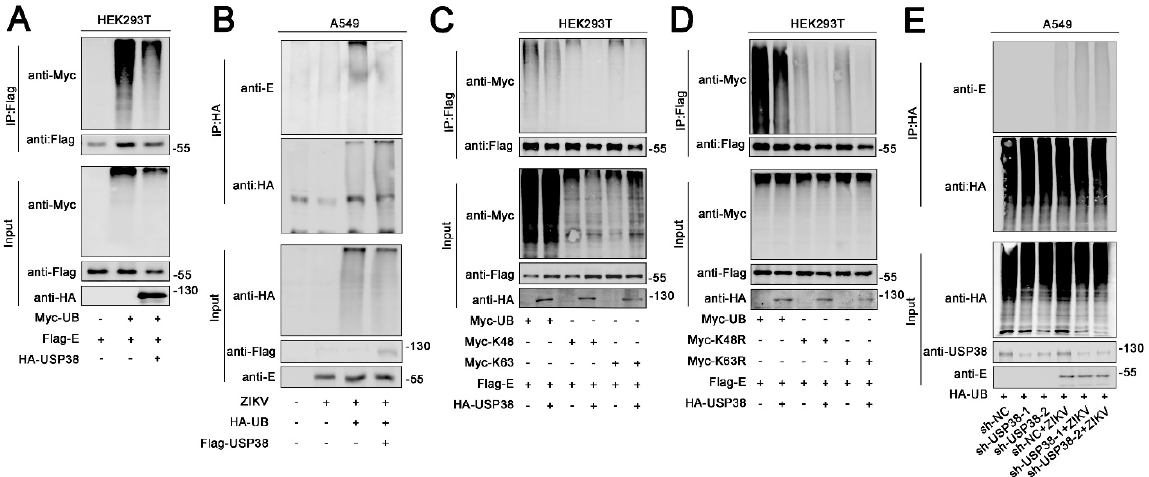
Figure 3. USP38 removes both k48-linked and K63-linked polyubiquitination of E protein. ( A ) HEK293T cells were co- transfected with Flag-E, HA-USP38, and Myc-UB. Cell lysates were immunoprecipitated with anti-Flag and immunoblotted with anti-Myc. ( B ) A549 cells were transfected with HA-UB, Flag-Vector or Flag-USP38 for 24 h then infected with ZIKV (1 MOI). Cell lysates were immunoprecipitated with anti-HA and immunoblotted with anti-E. ( C ) HEK293T cells were co-transfected with Flag-E, Myc-UB, Myc-k48, Myc-k63 together with HA-USP38. Cell lysates were immunoprecipitated with anti-Flag and immunoblotted with anti-Myc. ( D ) HEK293T cells were co-transfected with Flag-E, Myc-UB, MycK48R, Myc-k63R together with HA-USP38. Cell lysates were immunoprecipitated with anti-Flag and immunoblotted with anti-Myc. ( E ) A549 cells stably expressing sh-USP38 or control sh-RNA were transfected with HA-UB for 24h then infected with ZIKV 48h. Cell lysates were immunoprecipitated with anti-HA and immunoblotted with anti-E.